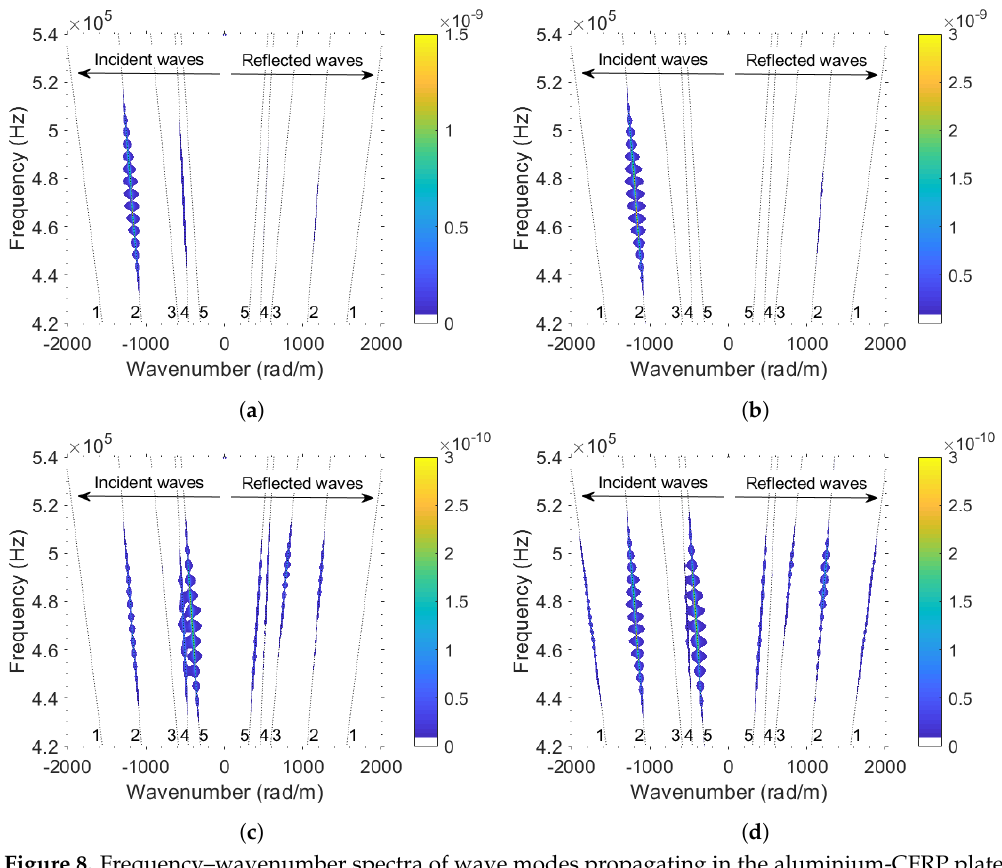
Figure 8. Frequency–wavenumber spectra of wave modes propagating in the aluminium-CFRP plate and reflecting from the 10mm delamination between the third and the fourth ply [Position (2)]: ( a ) for in-plane and ( b ) out-of-plane components while exciting Mode 2 at 475kHz, and ( c ) for in-plane and ( d ) out-of-plane components while exciting Mode 5 at 475kHz. Table 4. Comparison of the mode-damage interaction for the damage positioned in different parts of the structure. (cid:51) , modes which reflect from the damage; (cid:55) , modes which did not reflect from the